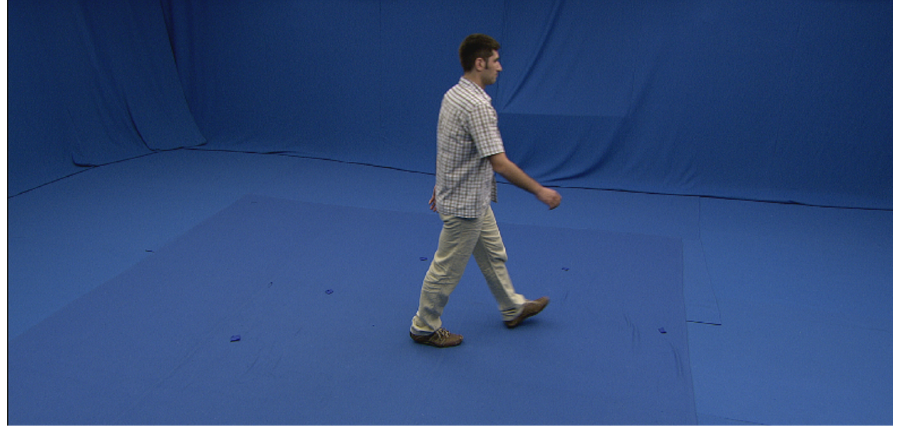
Figure 7. Uncompressed frame: Accuracy = 0.99.